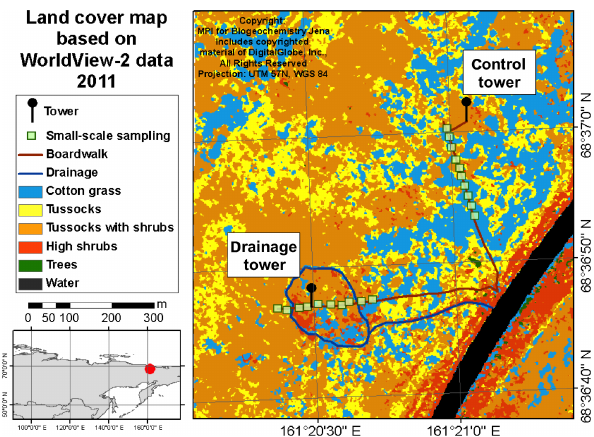
Figure 1. Land cover structure and instrumentation setup at the Chersky observation